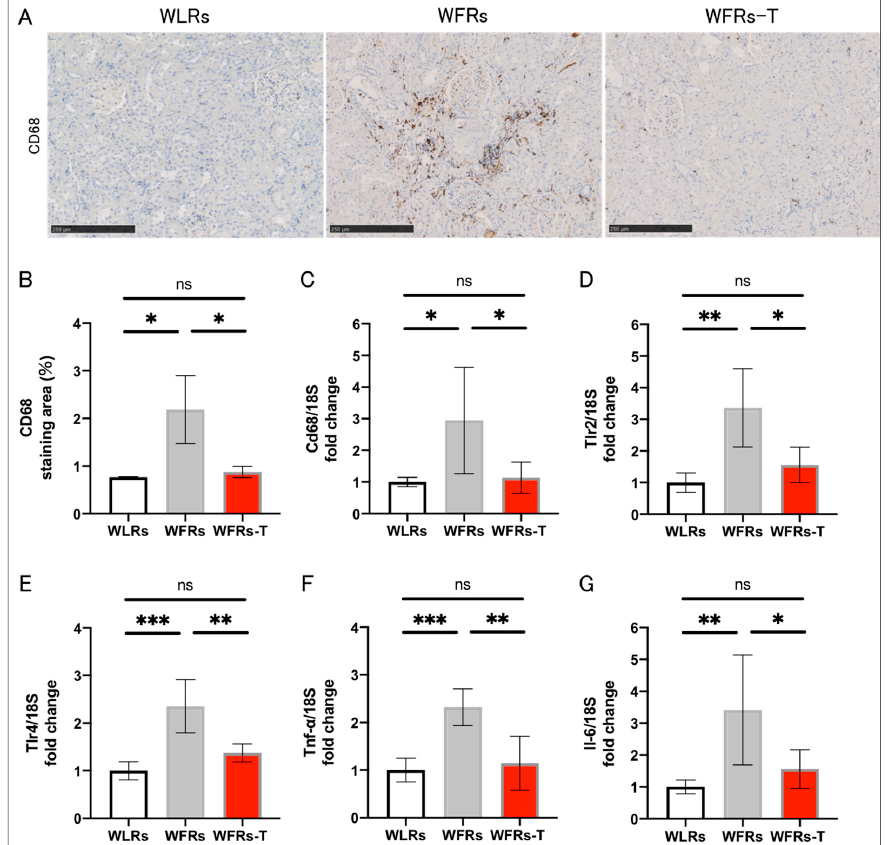
Figure 3. Changes in renal inflammation: ( A ) representative images of CD68 immunohistochemistry (scale bar: 250 μ m); ( B ) quantification of CD68 staining area ( n = 3); and mRNA expression of ( C ) Cd68, ( D ) Tlr2, ( E ) Tlr4, ( F ) Tnf- α , and ( G ) Il-6, adjusted to 18S levels in the cortex ( n = 5, respectively). All data are means ± standard deviation (SD). * p < 0.05, ** p < 0.01, *** p < 0.001, ns: not significant. Cd68, Cluster of differentiation 68; Tlr2, Toll-like receptor 2; Tlr4, Toll-like receptor 4; Tnf- α , tumor necrosis factor- α ; Il-6, interleukin 6; WLRs, sedentary Wistar lean rats; WFRs,